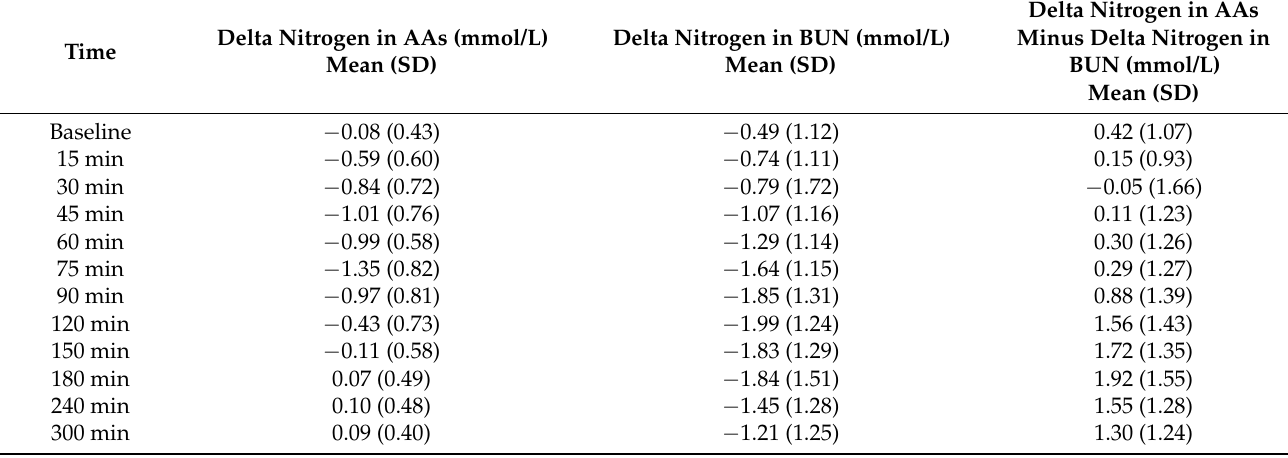
Table 3. Comparison of Delta nitrogen contained in amino acids with Delta nitrogen as blood urea nitrogen *.